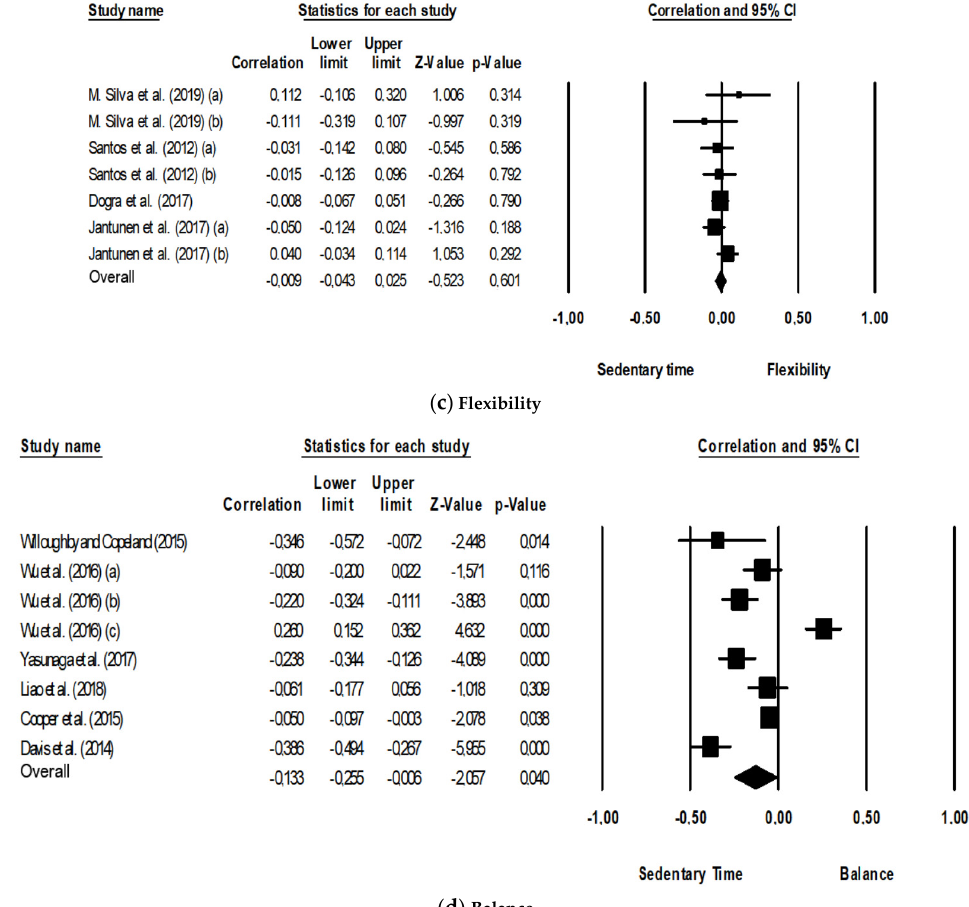
Figure 2. Forest plot for the association between objectively measured total ST and physical fitness components; ( a ) cardiorespiratory fitness; ( b ) muscular strength; ( c ) flexibility; ( d ) balance.